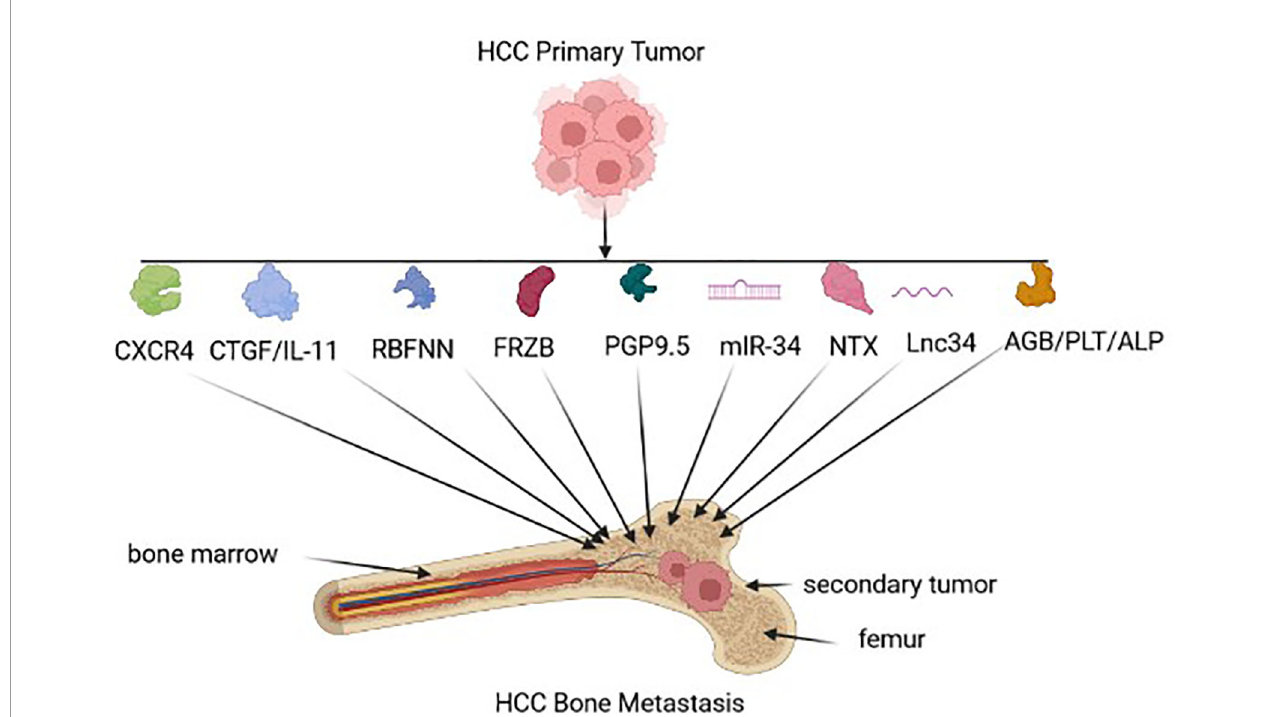
FIGURE 2 | HCC biomarkers for Bone metastasis. Early HCC-BM biomarkers expressed by the tumor-environment include chemokine receptor type 4 (CXCR4), connective tissue growth factor (CTGF)/interleuken 11(Il-11), radial basis function neural network (RBFNN) algorithm containing six peptides, Secreted Frizzled Related Protein 3 (FRZB), neuron cytoplasmic protein 9.5 (PGP 9.5), microRNA-34a (miR-34a), N-terminal telopeptide (NTx), long non-coding RNA 34 (Lnc34), hemoglobin (HGB)/ platelet count (PLT), alkaline phosphatase